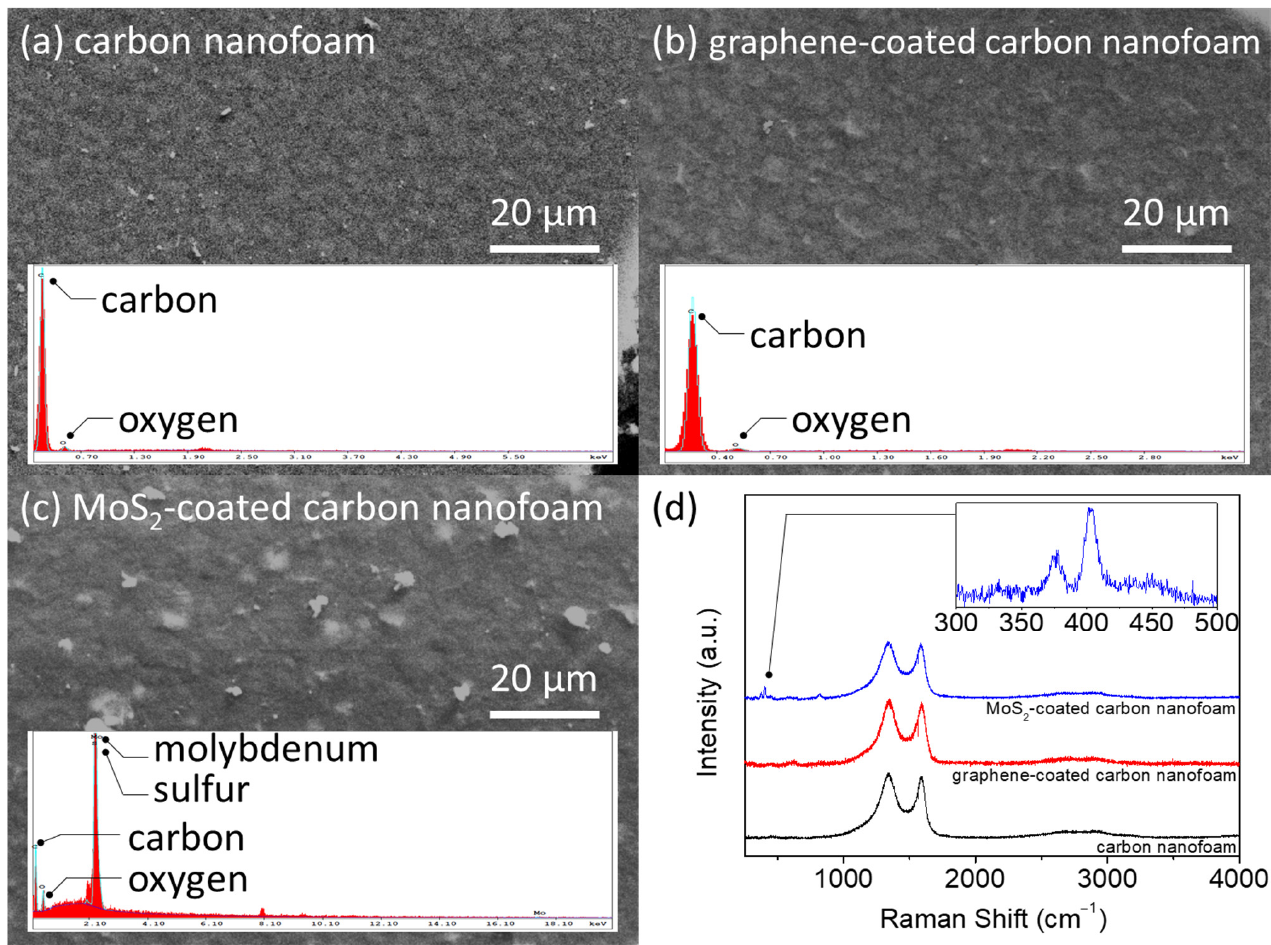
Figure 2. Chemical analysis: microstructural and elemental analyses of ( a ) carbon nanofoam, ( b ) graphene-coated carbon nanofoam, and ( c ) MoS 2 -coated carbon nanofoam. ( d ) Raman spectra.